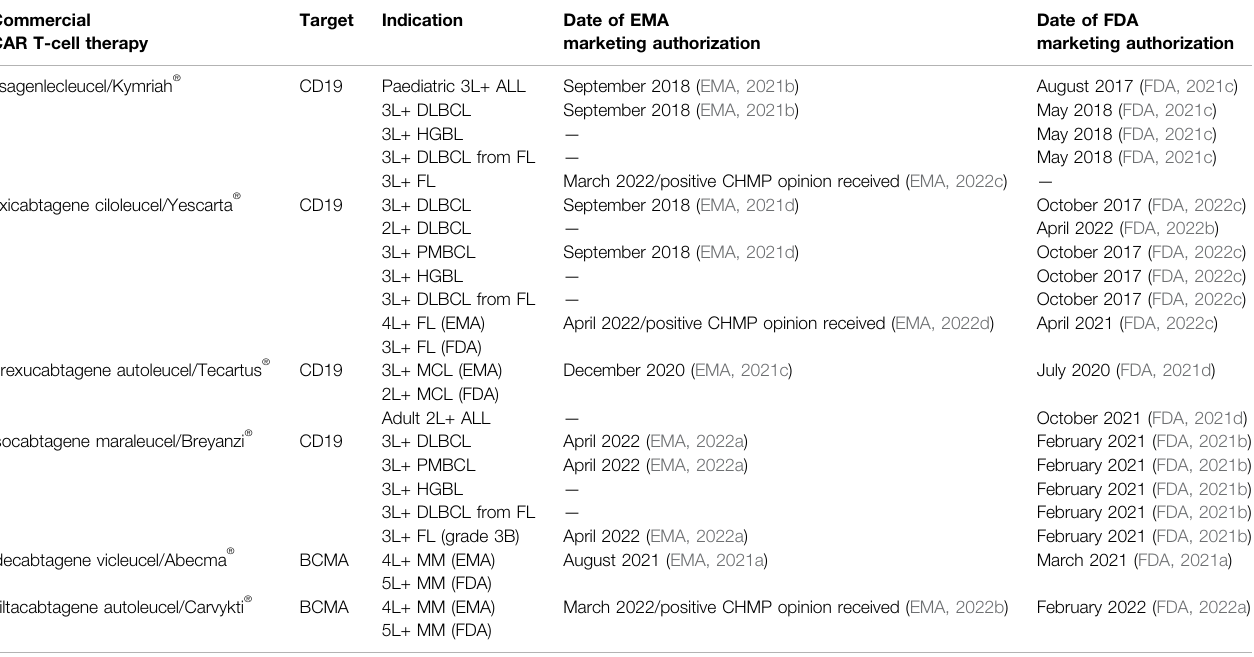
TABLE 1 | Commercial CAR T-cell therapies approved by the EMA and FDA (May